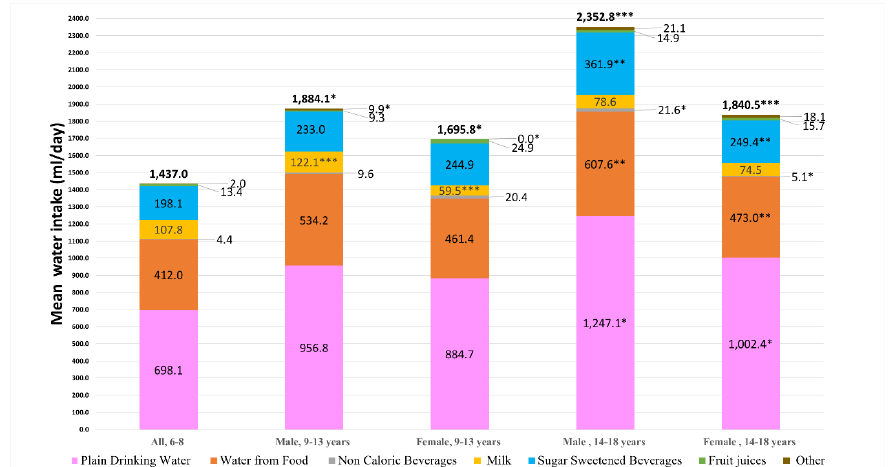
Figure 1. Comparison of mean water intake from various sources by age group and sex. Statistical comparisons of the means of water intake from each source of water were conducted between age and sex groups, using independent t -test. * p < 0.05; ** p < 0.01; *** p < 0.001. Sample: 6–8 years (n = 160),